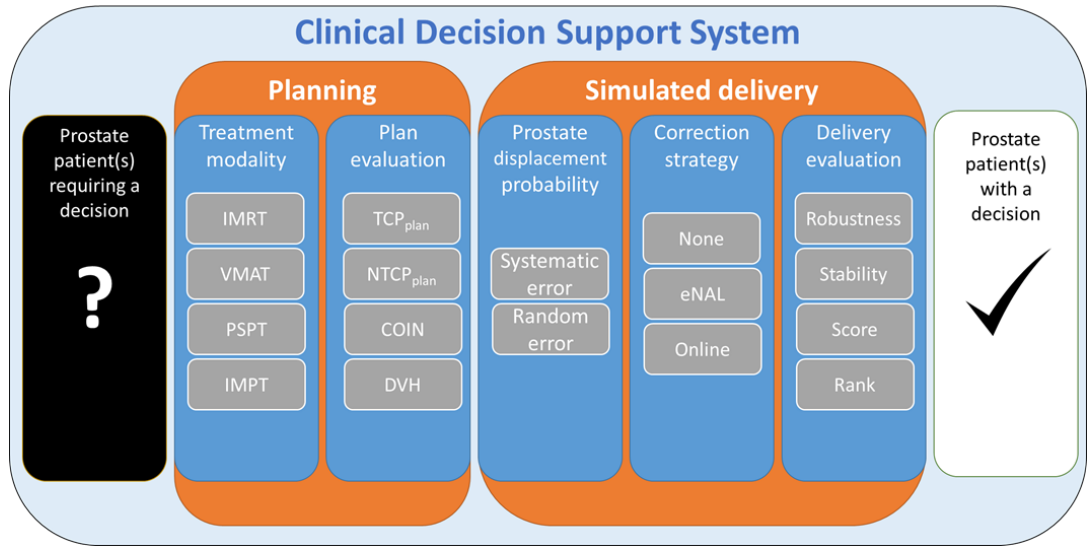
Figure 2. Workflow of this in silico trial (from left to right): The process begins with a prostate patient dataset. Each dataset is entered into the planning stage, where a plan is created for all possible treatment modalities. Subsequently, each plan is evaluated by dose metrics and radiobiological models. Next, each plan is entered into the simulated delivery stage, where known likely clinical errors (target motion) along with correction strategies are introduced/simulated into the plan/delivery. Subsequently, each plan is evaluated in terms of robustness and stability, which in turn produces a score and finally a rank. This enables two conclusions to be made for these clinical conditions, planning criteria, and simulations parameters: (1) which modality is ranked highest across the cohort, and (2) which modality is ranked highest for each individual patient.